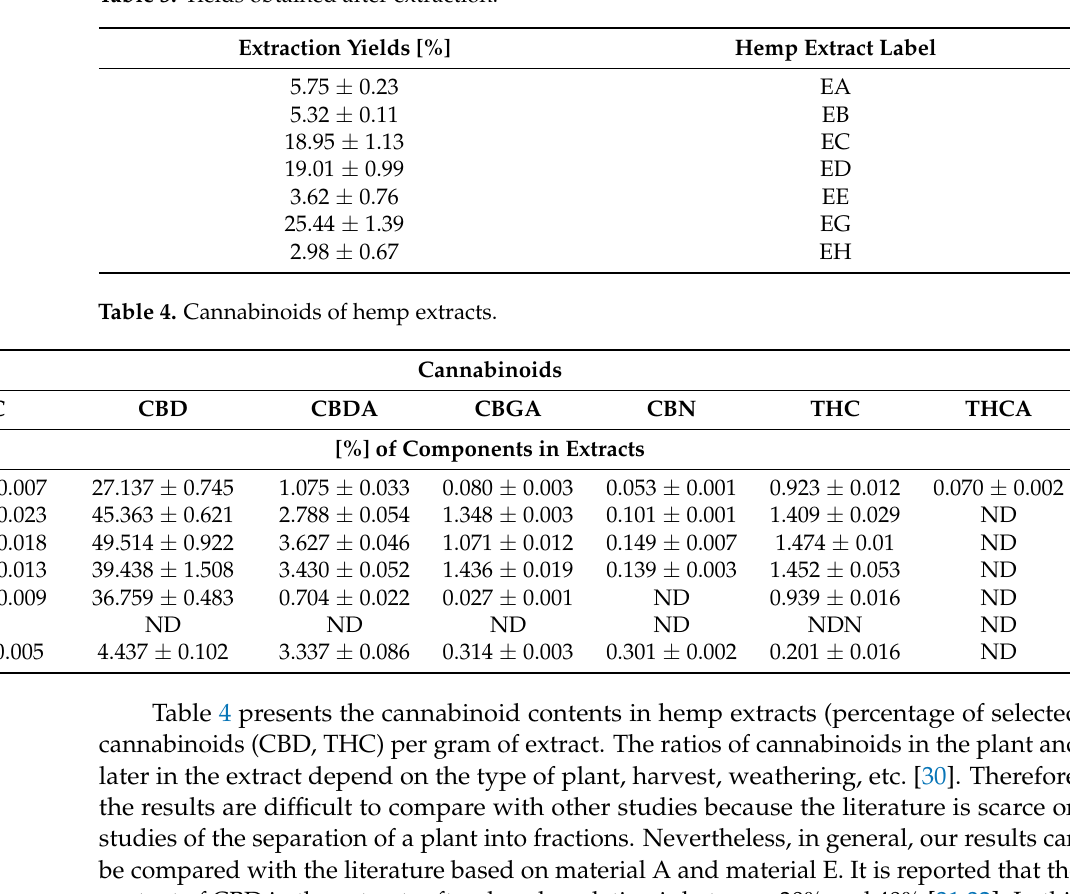
Table 3. Yields obtained after extraction.